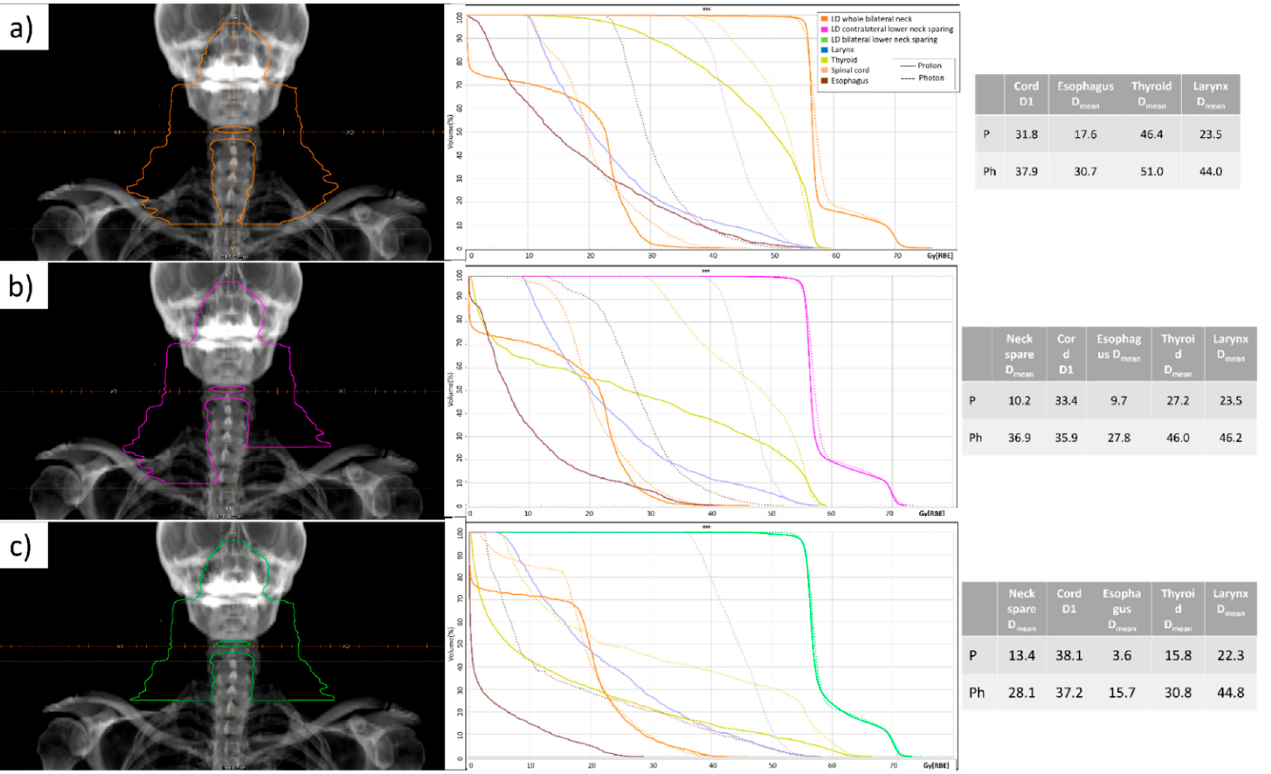
Figure 1. Dose map comparison. Low risk CTV with ( a ) whole bilateral neck; ( b ) contralateral lower-neck sparing; ( c ) bilateral lower-neck sparing according to [11]. In all cases target volumes were planned to receive 56 Gy [RBE] in 33 fractions, according to study protocol. In the three columns for each case, the following were reported, respectively: DDRs with the relative target; IMPT (continuous) versus IMRT (scattered) plans DVH for the low-dose target and selected OARs; dose values (Gy[RBE]) for the selected OARs.